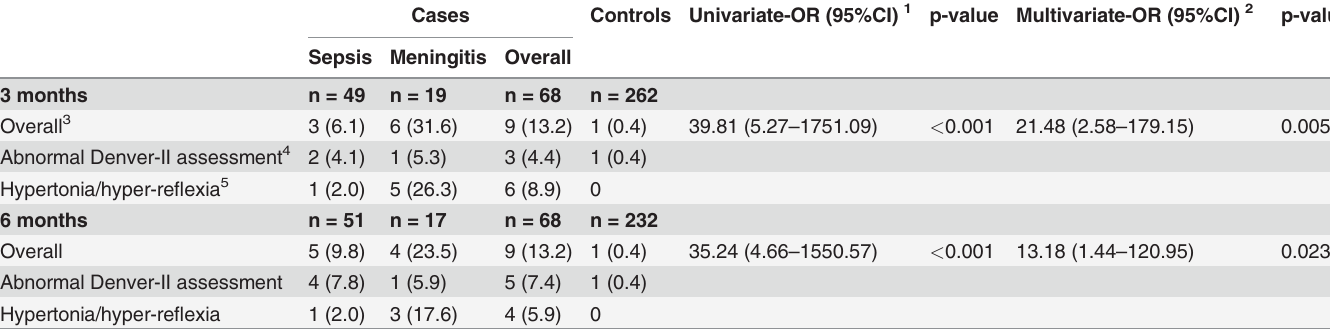
Table 4. Neurological sequelae of infants with invasive Group B Streptococcus (GBS) disease at 3 and 6 month visits. Cases